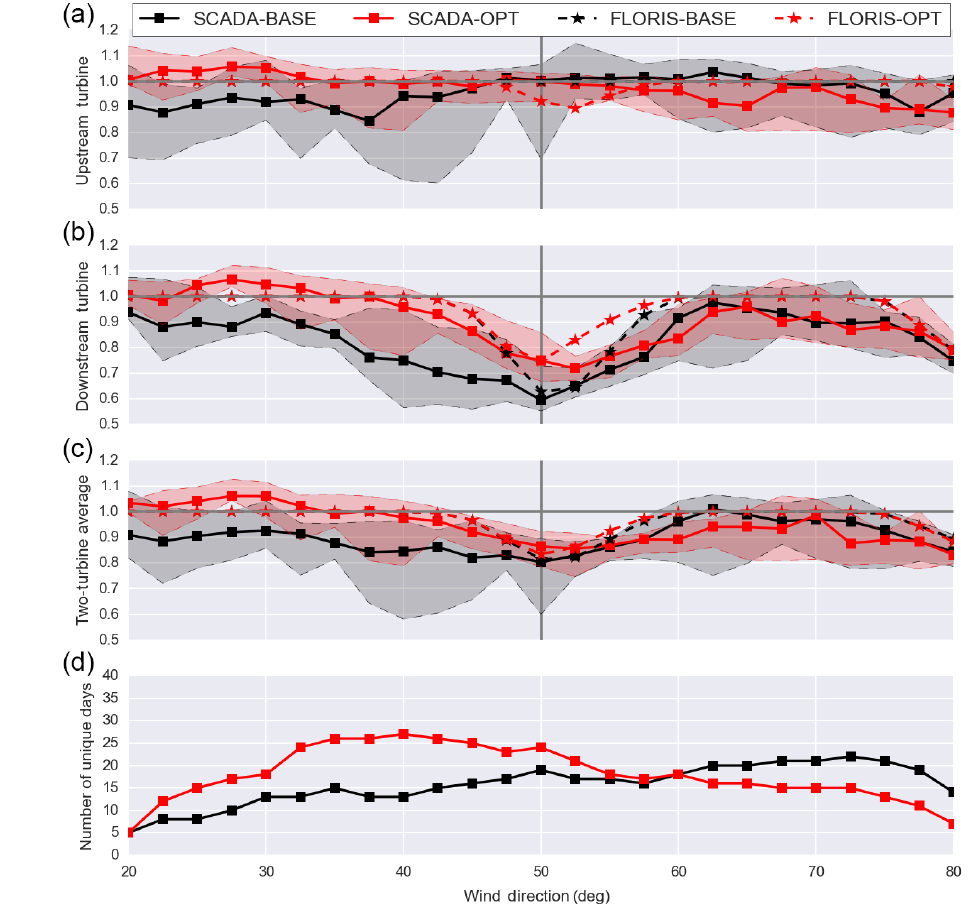
Figure 7. This figure shows the results of the turbine C1 to turbine D2 pair. In particular, (a) shows turbine C1 and the resulting power with the controller on (red) and off (black). Panel (b) shows the downstream turbine, i.e., turbine D2, with the controller on (red) and off (black). Panel (c) shows the overall power between the pair of turbines. Finally, (d) indicates the number of days used to compute the statistics provided in the top three